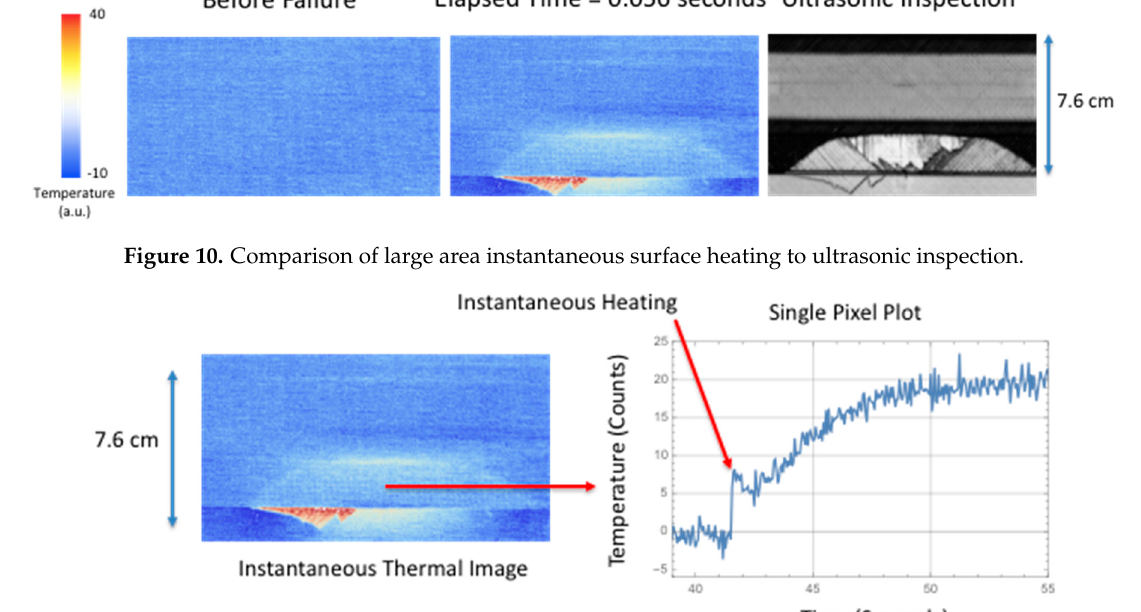
Figure 9. Single pixel plot of instantaneous surface heating.